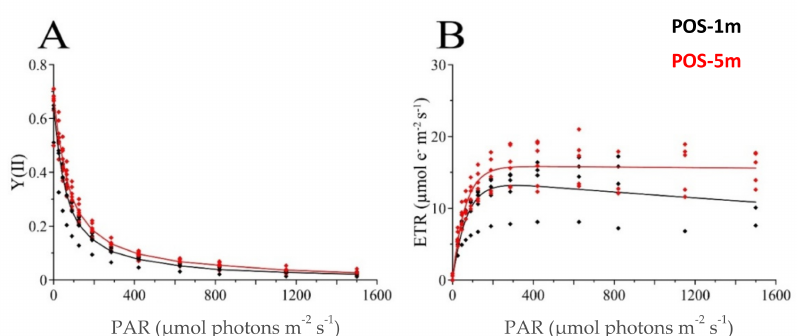
Figure 4. RLCs curves of P.oceanica sampled during POSI-Jun. ( A ) Y(II) and ( B ) ETR as a function of PAR. Squared dots represent all the measures, while the continuous curvesare given by the median values and the fits calculated according to [75].